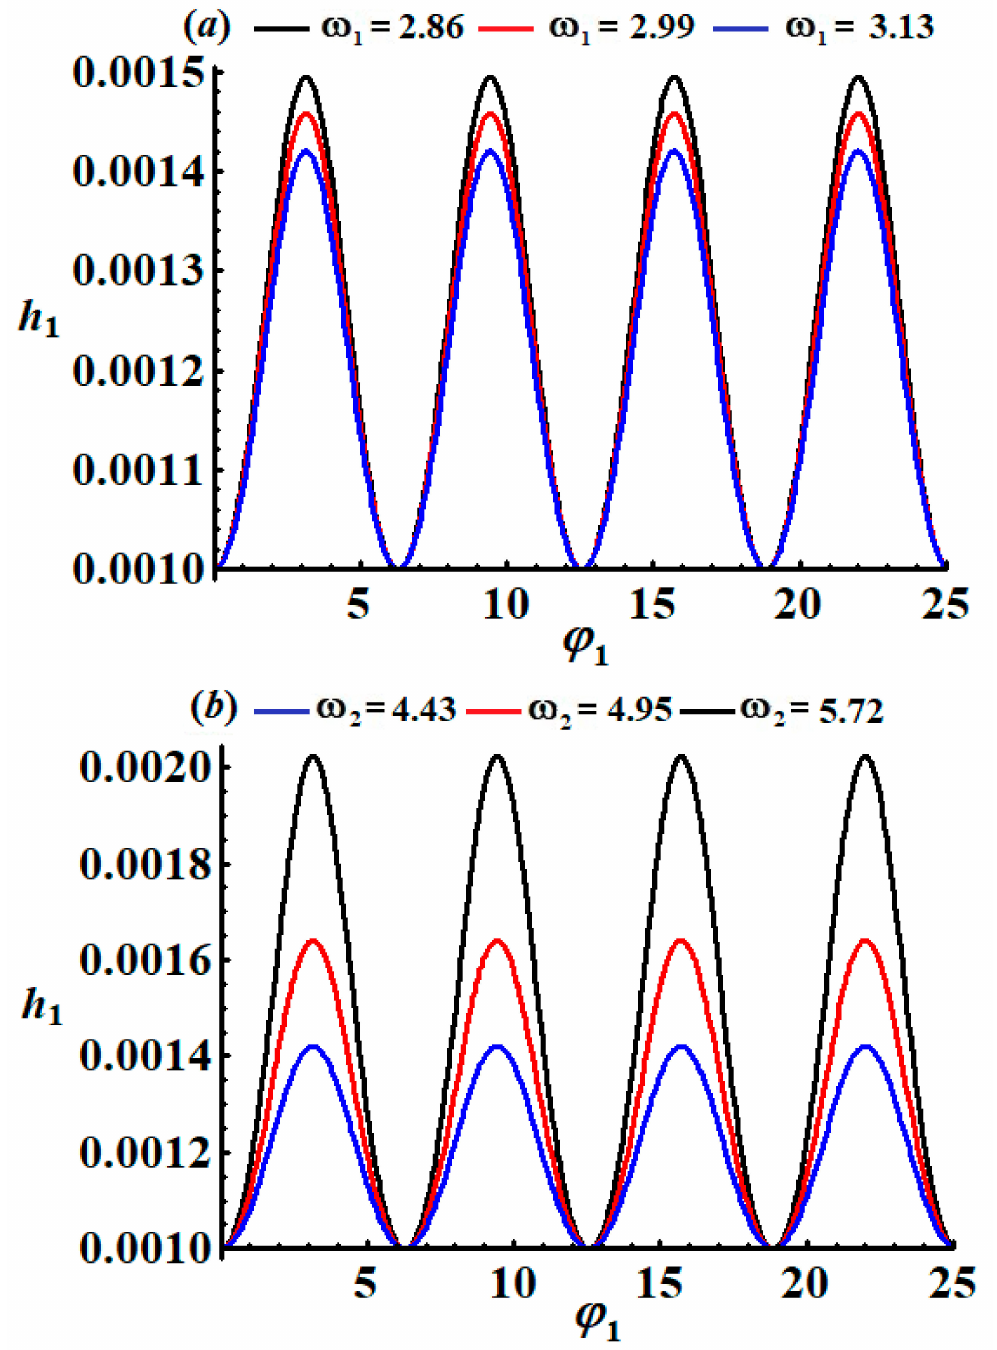
Figure 7. Description of the modulation for the amplitude h 1 as a function of ϕ 1 : ( a ) at ω 1 = ( 2.86,2.99,3.13 ) , ( b ) at ω 2 = ( 4.43,4.95,5.72 )